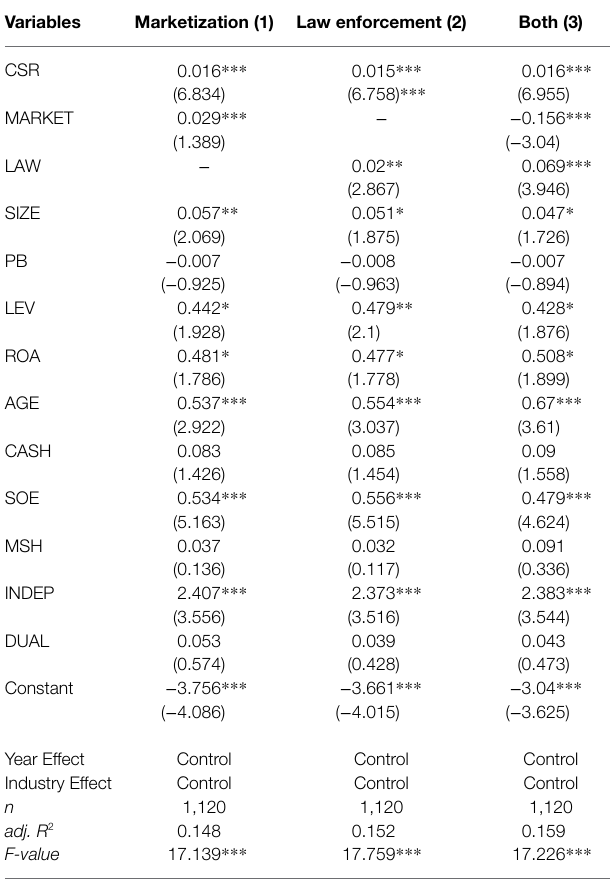
TABLE 5 | Controlling for the effects of marketization and law enforcement.